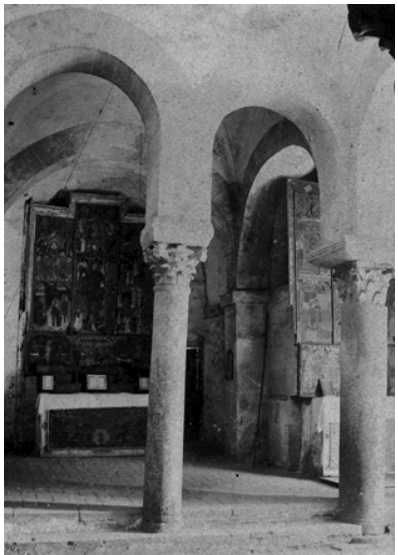
Figure 6. Inside of the church of Sant Miquel, c. 1878. Author: Adrià Torrija. © Museu de Terrassa, MdT 18955.